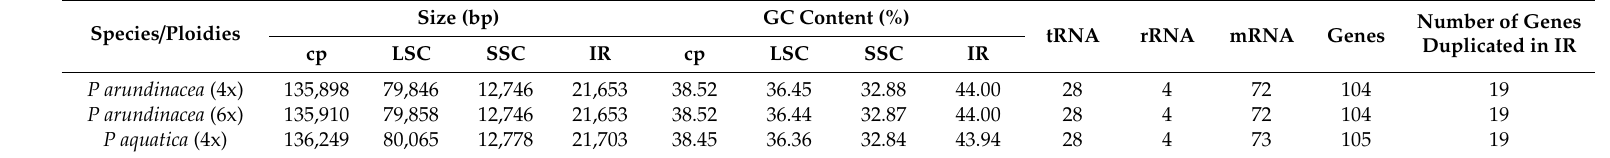
Table 1. Comparison of the three Phalaris chloroplast (cp) genomes.